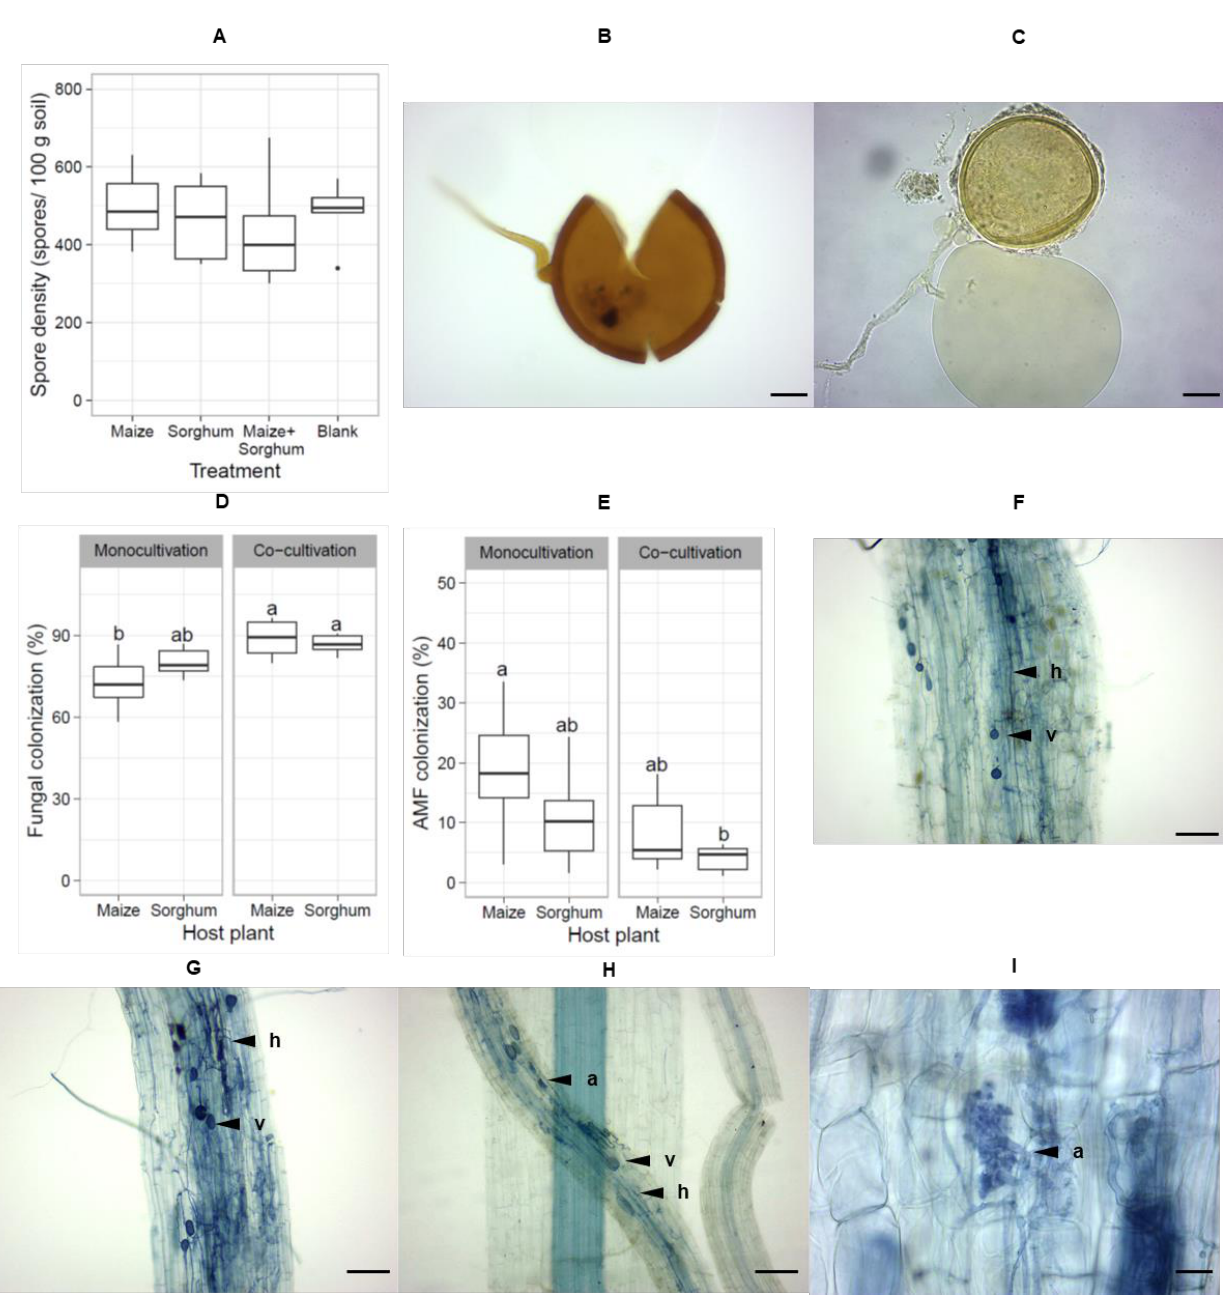
Figure 4. AMF spore density and root length colonization by fungi and AMF after the first trap culture. AMF spore densities were counted from mono-cultivation trap cultures containing maize or sorghum, a co-cultivation trap culture containing maize and sorghum and a trap culture without host plants as a blank ( A ). Glomus spores were observed under the light microscope (40× objective magnification, scale = 20 µm) ( B , C ). Degrees of fungal colonization ( D ) and AMF colonization ( E ) in roots from each treatment were compared. Mycorrhization structures such as hyphae ( h ), vesicle ( v ) and arbuscule ( a ) were observed under the light microscope (150 views, 10× objective magnification, scale = 100 µm) ( F – H ). Mature arbuscules were present in the host roots (scale = 20 µm) ( I ). The box plots show the distribution of data in each trap culture condition ( n = 6 biological replicates). Statistical analysis was performed by one-way ANOVA following LSD. Different letters indicate significant differences ( p < 0.05).